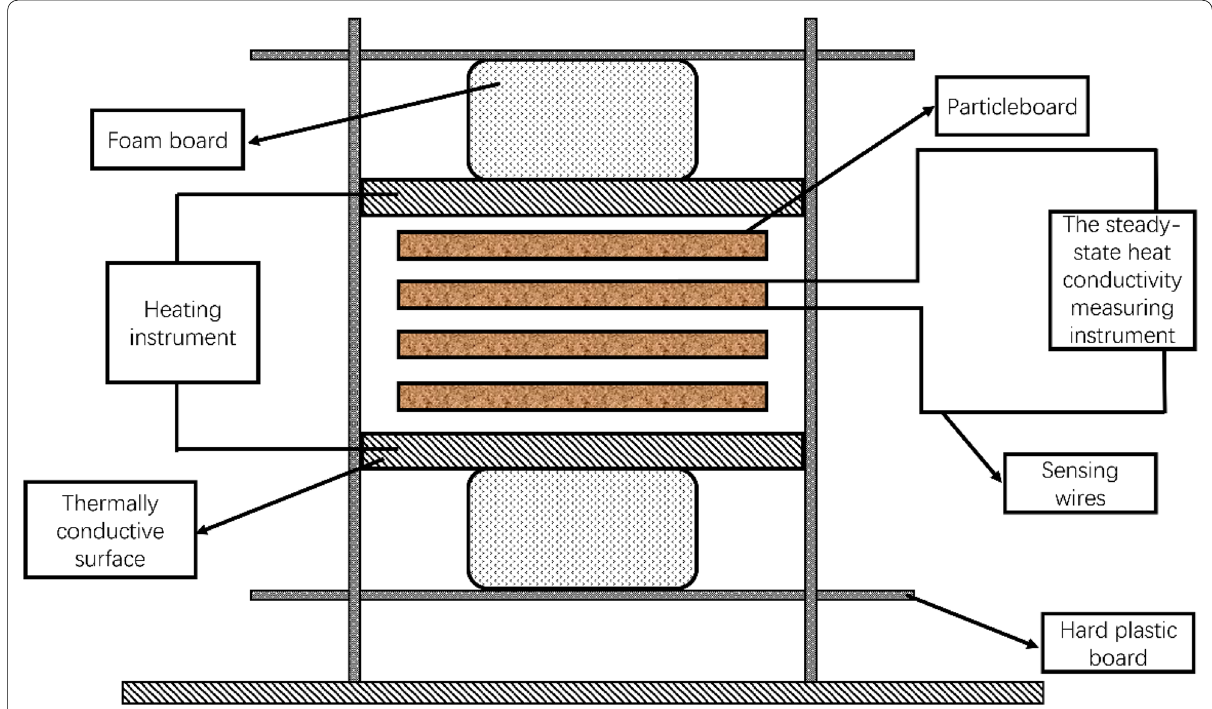
Fig. 1 Schematic diagram of heat conductivity testing of particleboard with various